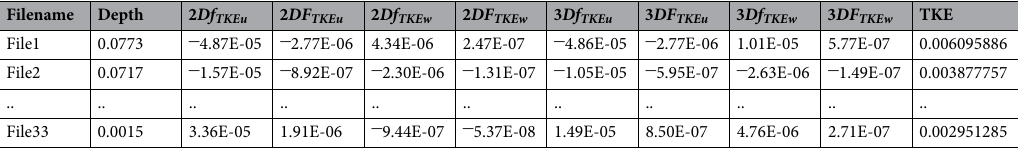
Table 7. Statistical parameters of turbulence obtained via P-SAT (Continued...).